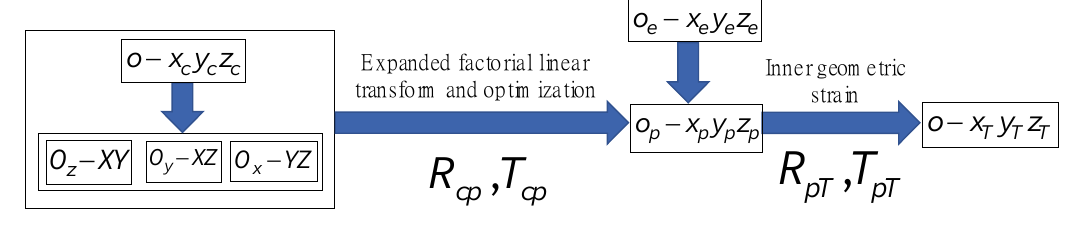
Figure 1. Method flowchart.